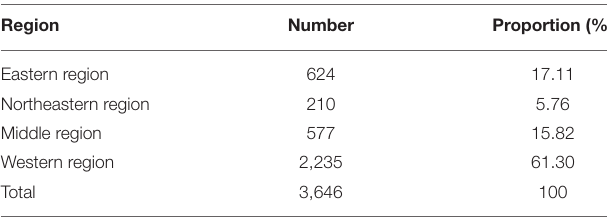
TABLE 6 | The regions of wildlife crimes.